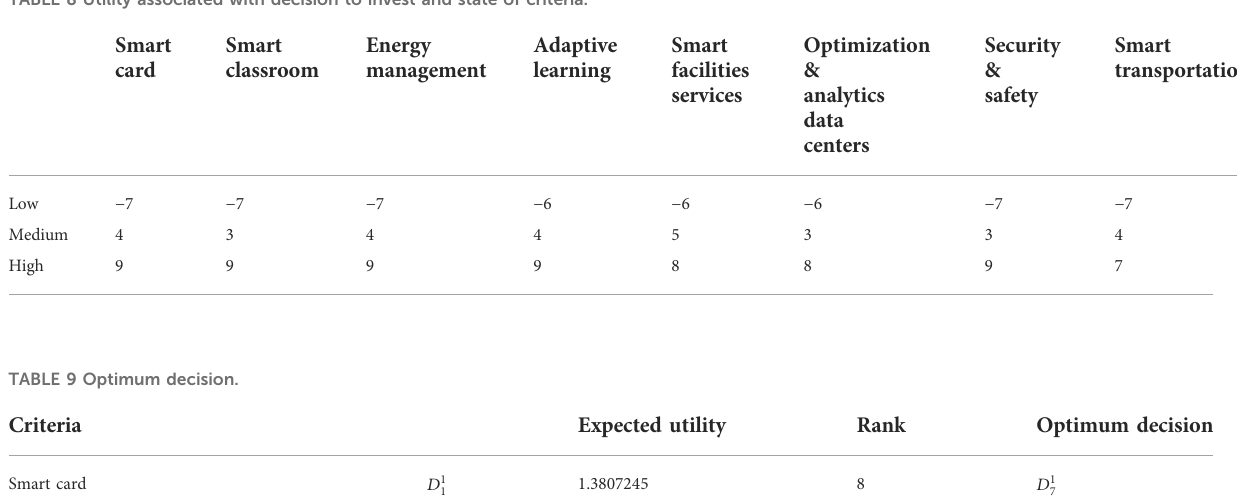
TABLE 8 Utility associated with decision to invest and state of criteria.